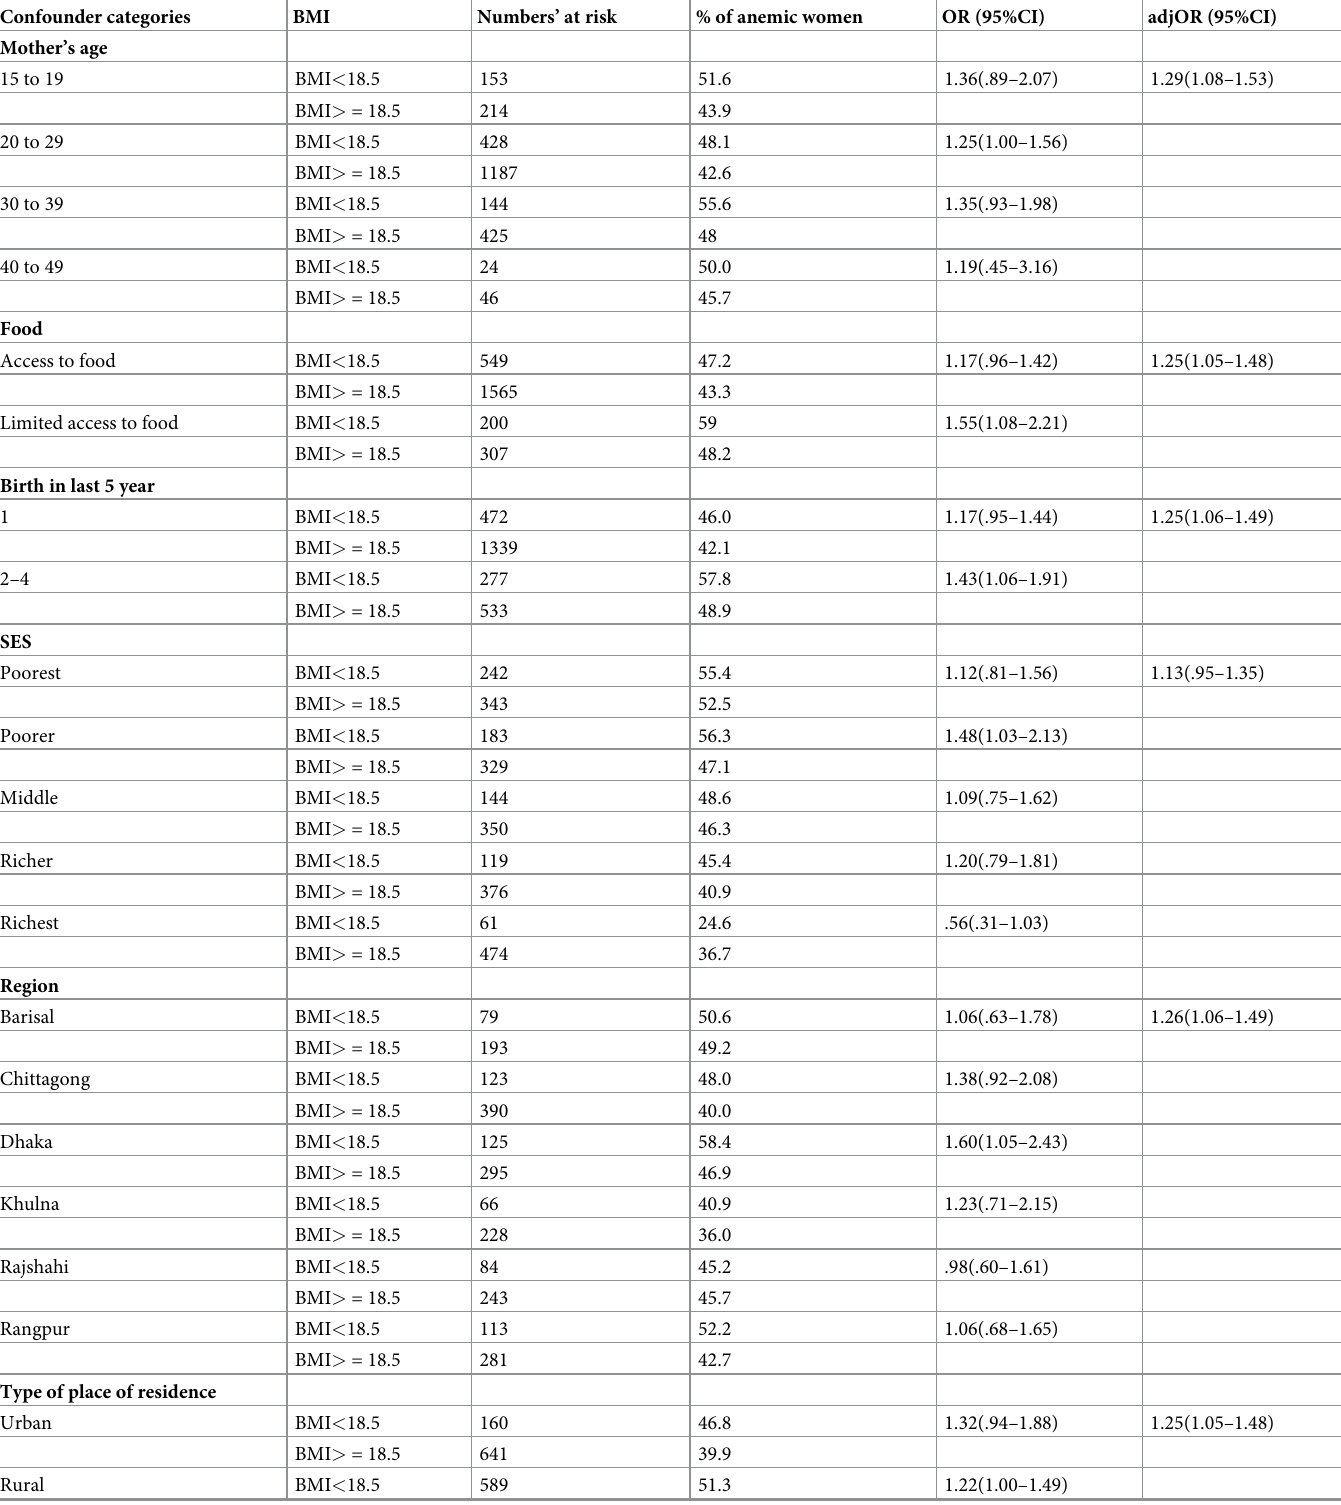
Table 4. Association between BMI and anemia in women of age 15–49